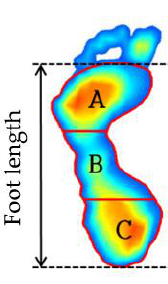
Figure 2. Arch index calculation method.